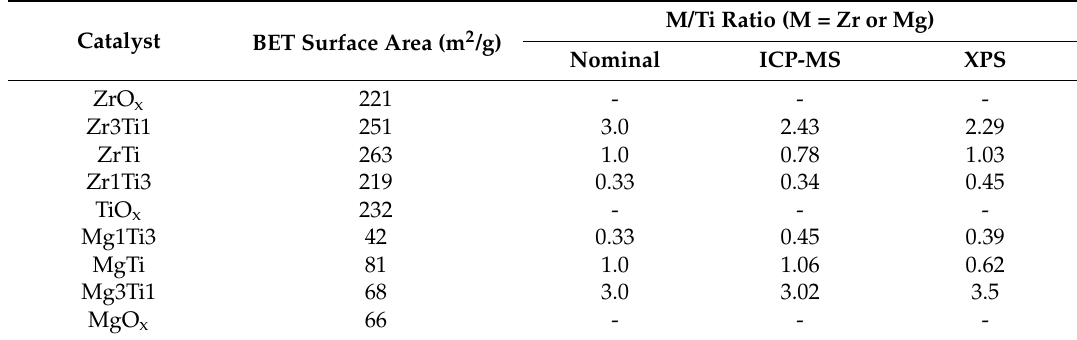
Table 1. Brunnauer–Emmett–Teller (BET) surface area and atomic composition (nominal and experimental) of the different solids synthesized in the present